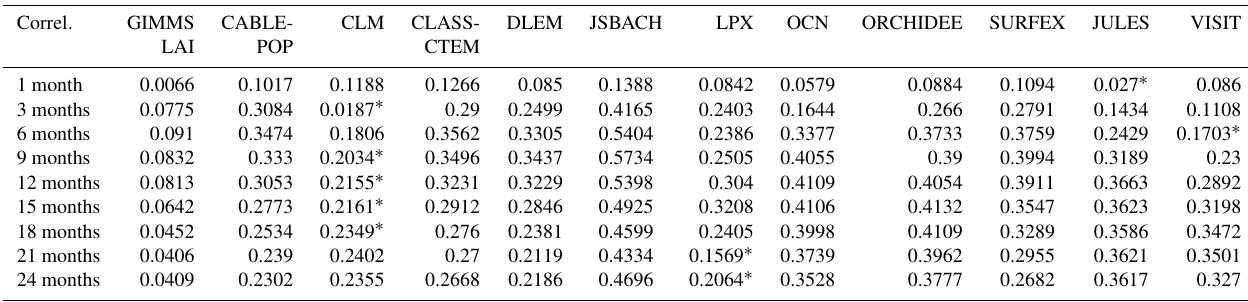
Figure 8. Mean correlation (observed and multimodel ensemble) of annual LAI and SPEI for 1982–2011 across latitudes over southern Africa for 1- to 24-month timescales. Table 4. Model simulation of mean SPEI and LAI correlations between 1982 and 2011. The asterisk ( ∗ ) indicates the model with the lowest mean